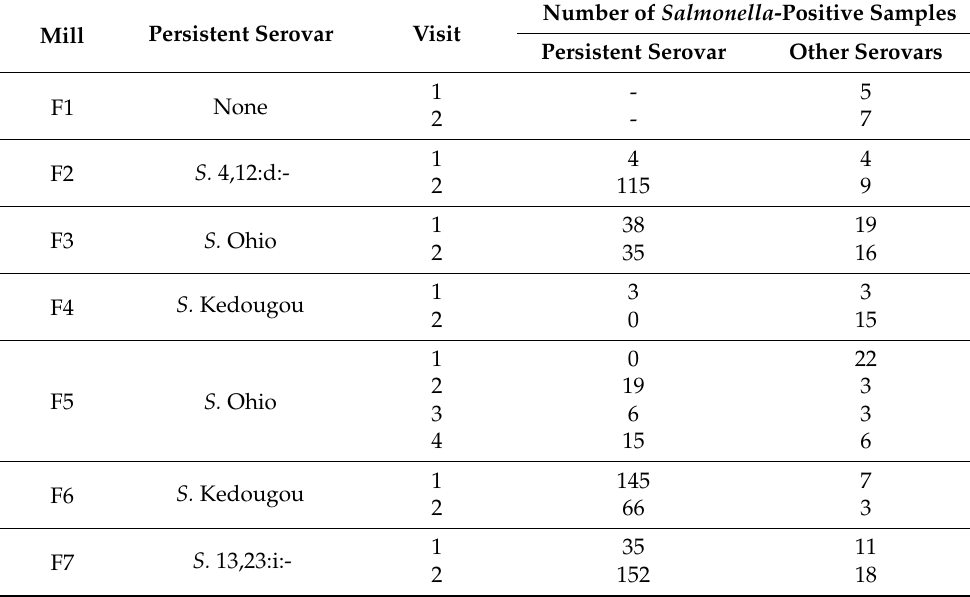
Figure 3. Number of different Salmonella serovars isolated from each mill at each of one to four visits. Table 3. Occurrence of Salmonella serovars at repeat visits.